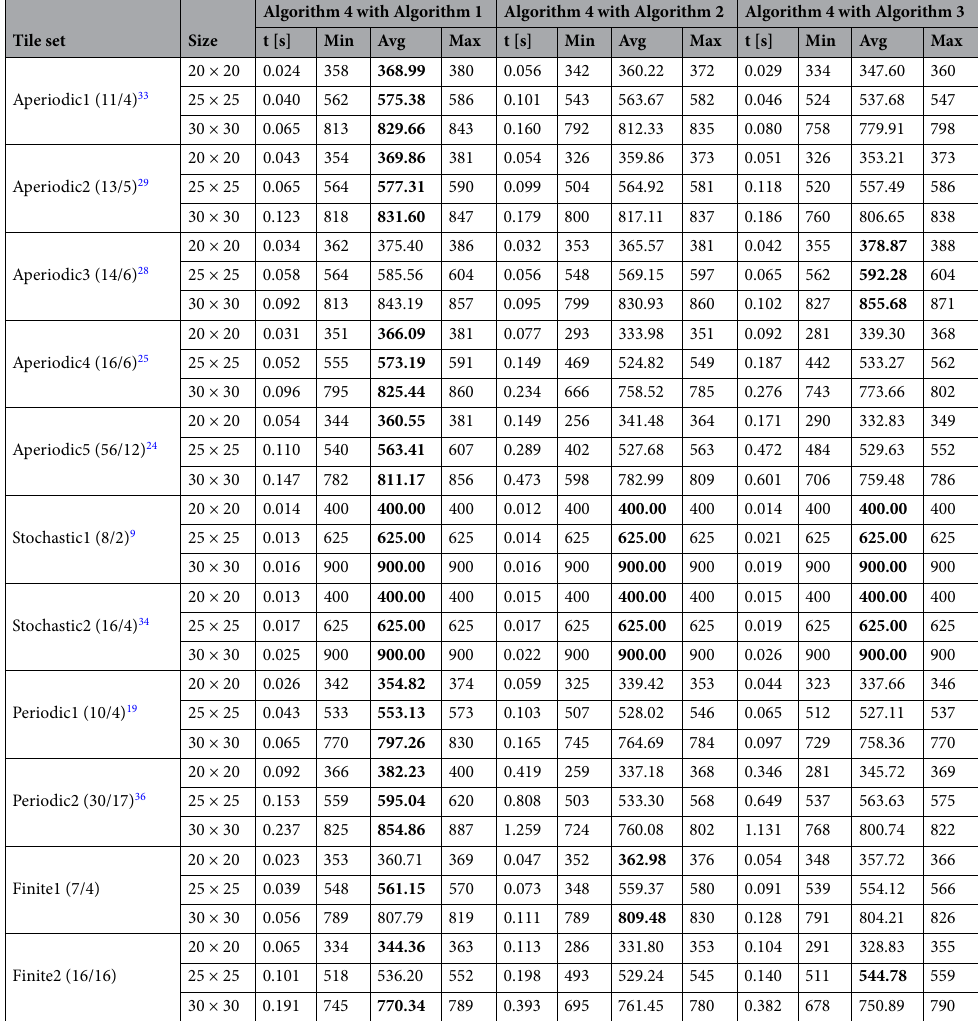
Algorithm 4 with Algorithm 1 Algorithm 4 with Algorithm 2 Algorithm 4 with Algorithm